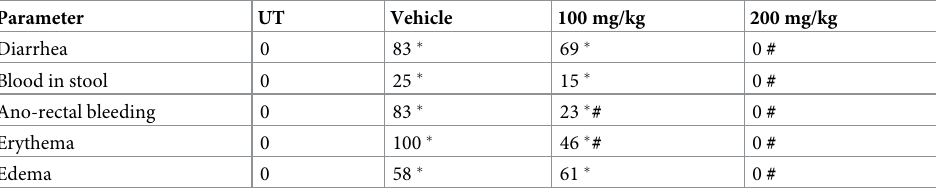
Table 2. Effect of OBE on the macroscopic scores for colitis severity using the preventative approach. Parameter UT Vehicle 100 mg/kg 200 mg/kg Diarrhea 0 83 � 69 � 0 # Blood in stool 0 25 � 15 � 0 # Ano-rectal bleeding 0 83 � 23 � # 0 # Erythema 0 100 � 46 � # 0 # Edema 0 58 � 61 � 0 # Colitis severity was assessed in untreated (UT) mice, and in mice treated with DSS plus either vehicle or OBE. Numbers of mice in each group are as follow: UT (n = 7), DSS/vehicle (PBS) (n = 12), DSS/OBE 100 mg/kg (n = 13), and DSS/OBE 200 mg/kg (n = 7). � denote significant difference from UT mice # denote significant difference from DSS/vehicle-treated